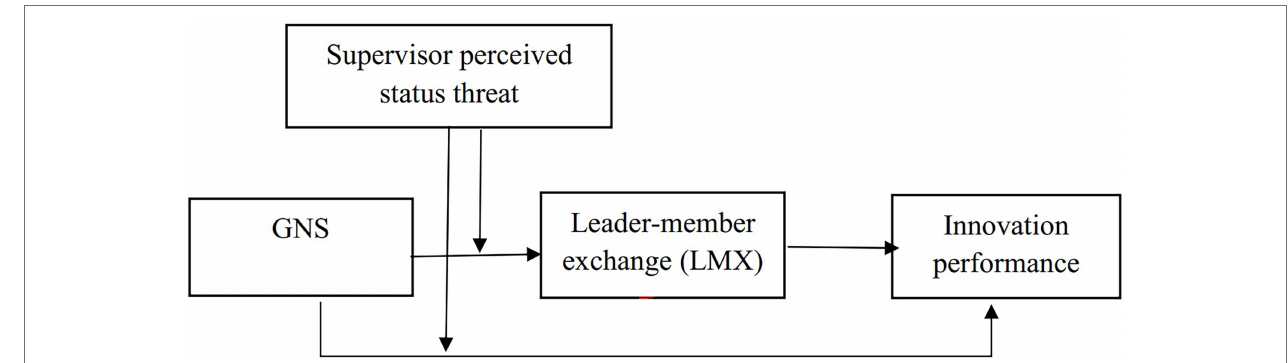
FIGURE 1 | Theoretical model of the